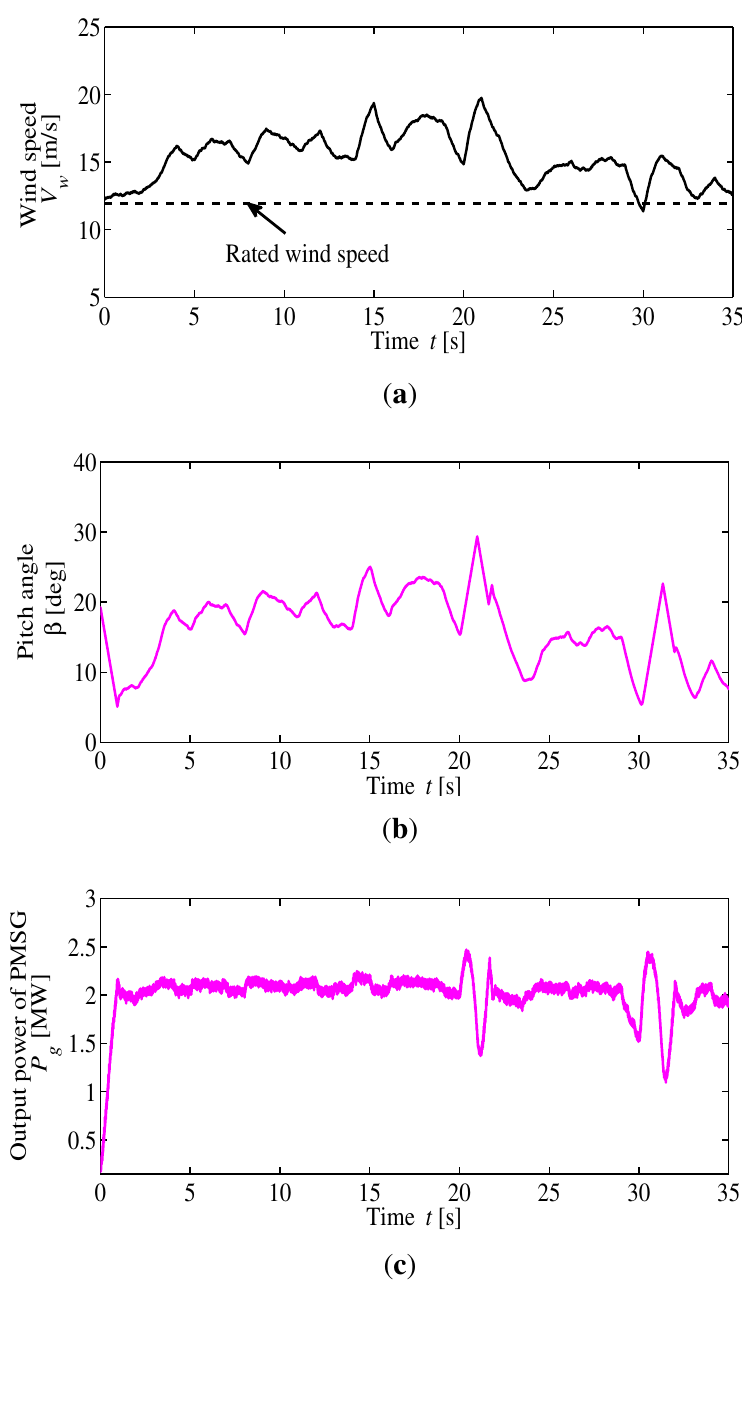
( b ) Pitch angle; ( c ) Output power of PMSG; ( d ) DC-link voltage; ( e ) DC-link current; ( f ) Output power of grid-side